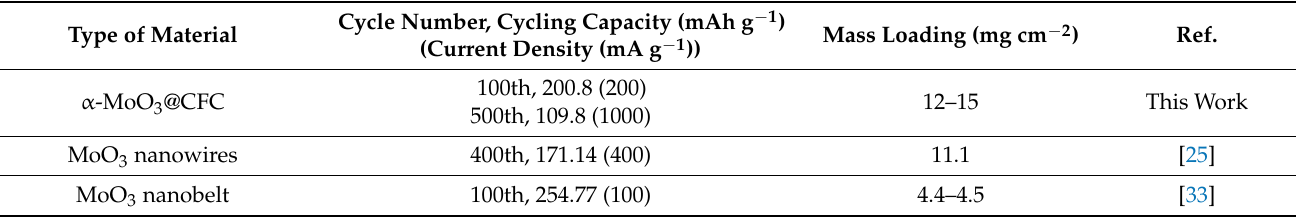
Table 1. Comparison of electrochemical properties of α -MoO 3 @CFC and reported aqueous zinc-ion cathode